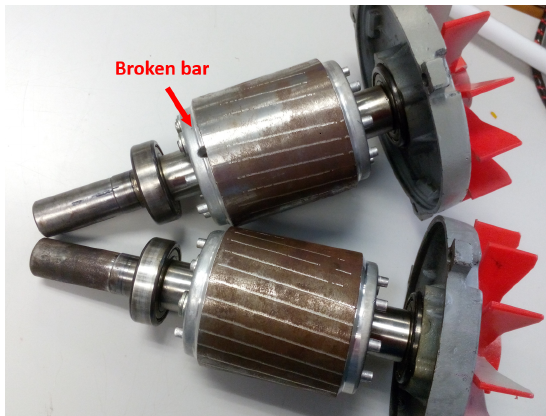
Figure 12. Top rotor with an artificially rotor broken bar fault and bottom rotor in healthy conditions.